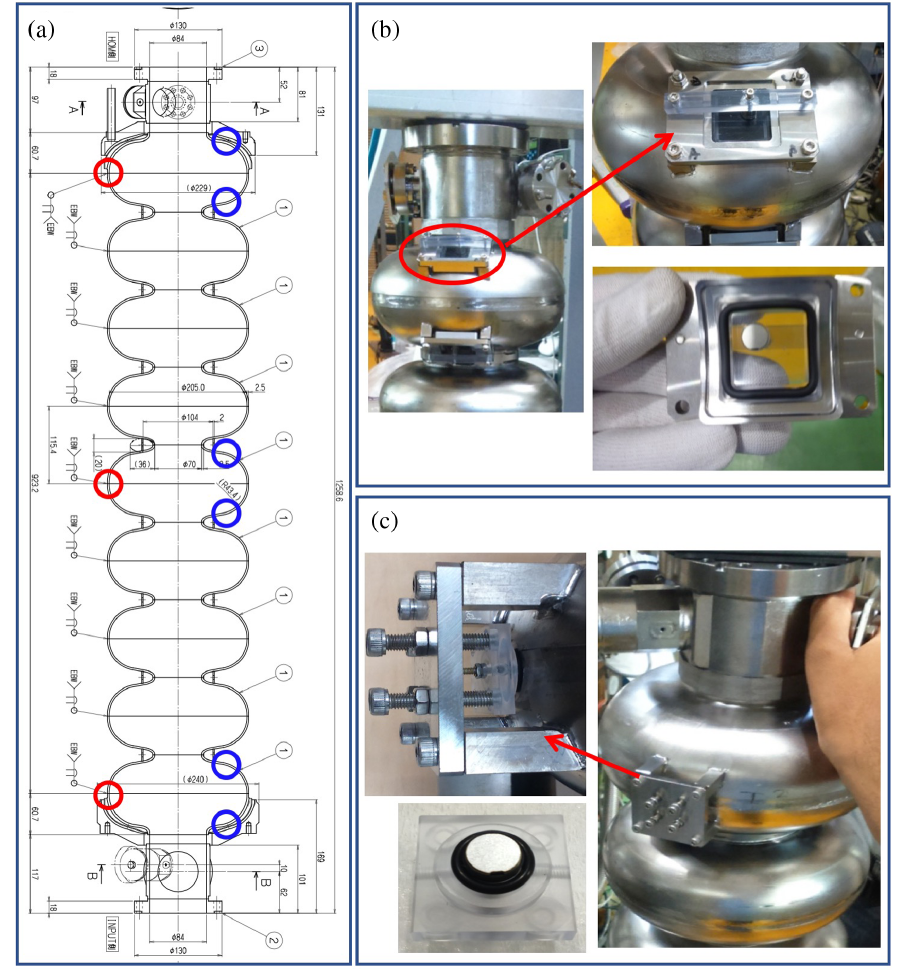
FIG. 2. (a) Diagram of the nine-cell coupon cavity with the nine coupon positions in the first, fifth, and ninth cells as represented with the circles on the cavity drawing. The blue circles represent coupons with viewports near the iris positions. The red circles represent the coupons without viewports at the equator positions. (b) Photographs of one of the iris coupons fixed on the viewport. (c) Equator coupon with the coupon